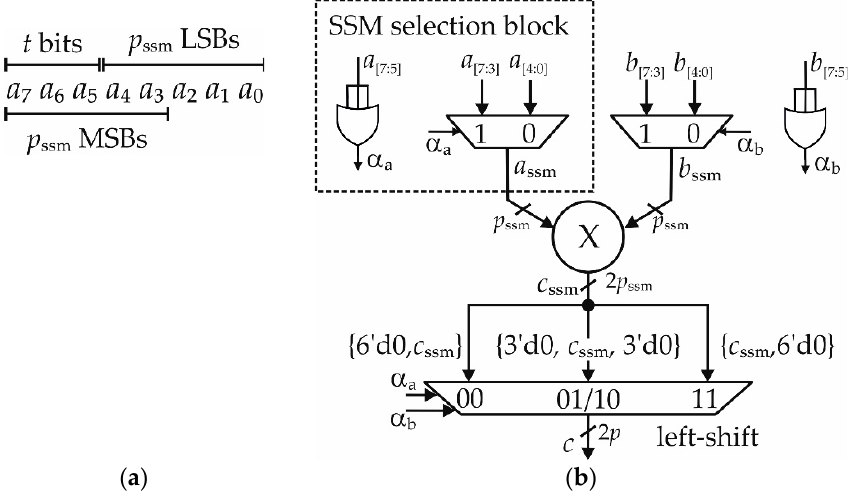
Figure 8. ( a ) Working principle of the SSM approximation, and ( b ) scheme of the SSM multiplica-